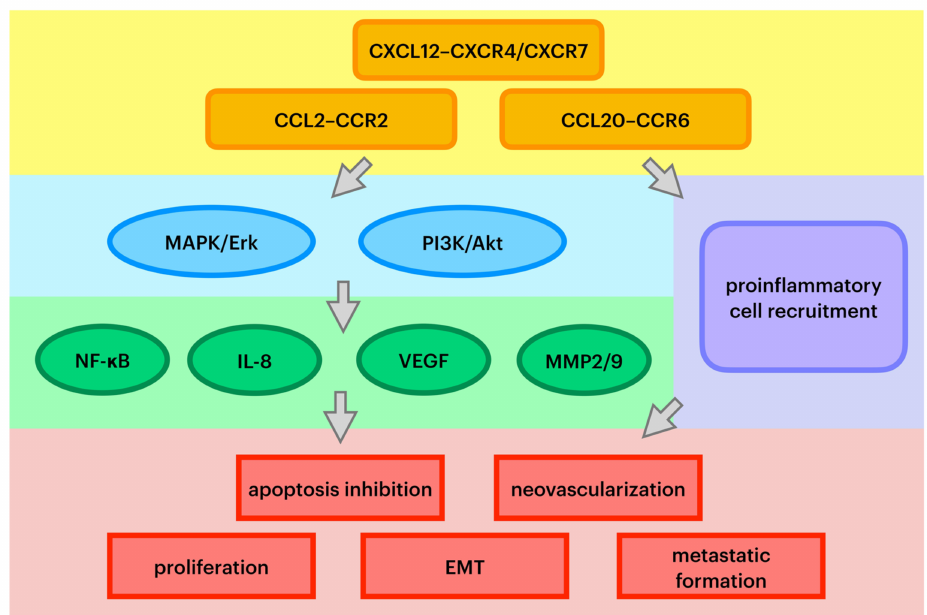
Figure 1. Key pathways of chemokines’ oncogenic effect. MAPK/Erk—mitogen-activated protein kinase/extracellular signal-regulated kinase; PI3K—phosphoinositide 3-kinase; NF- κ B— nuclear factor kappa-B; IL-8—interleukin 8; VEGF—vascular endothelial growth factor; MMP2/9— metalloproteinases 2 and 9; EMT—epithelial–mesenchymal